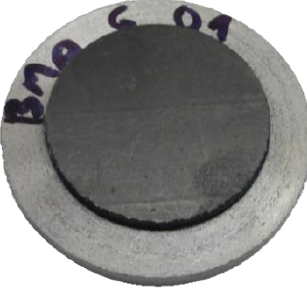
Figure 3. Image of a sample used for evaluation of the BP material’s permeability for hydrogen.